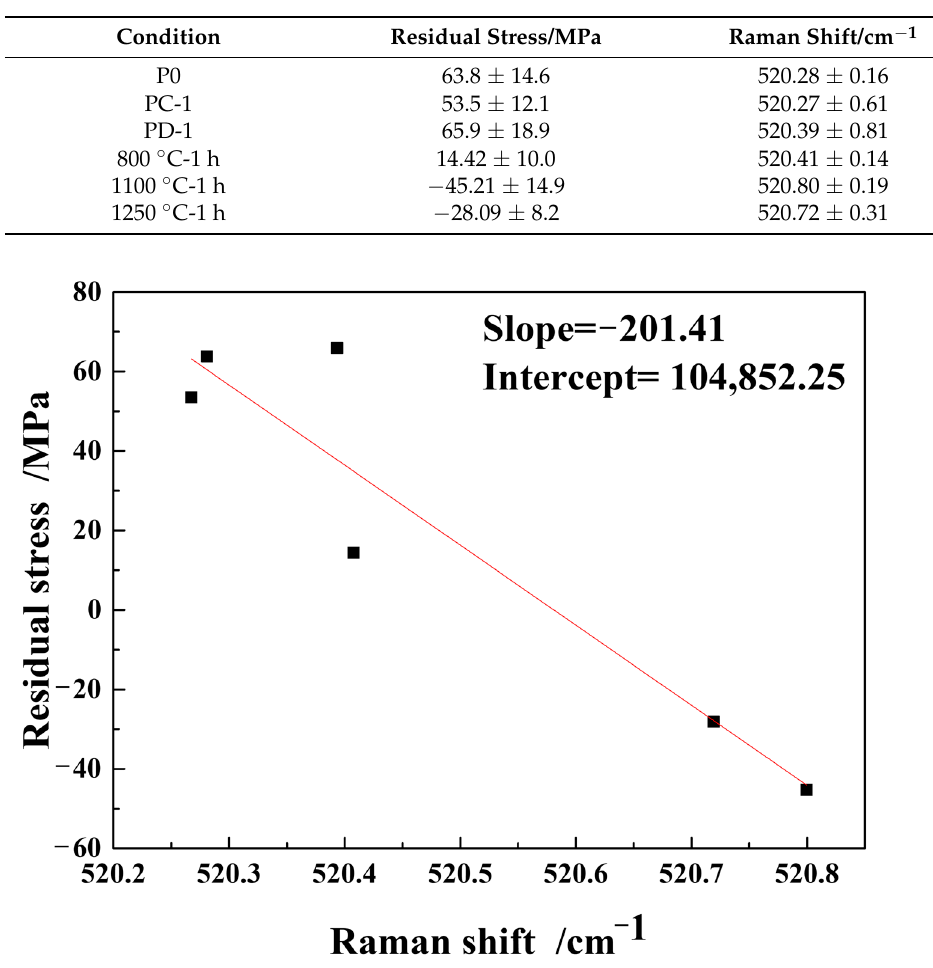
Table 5. Measurements of residual stress and Raman shift in typical coatings.